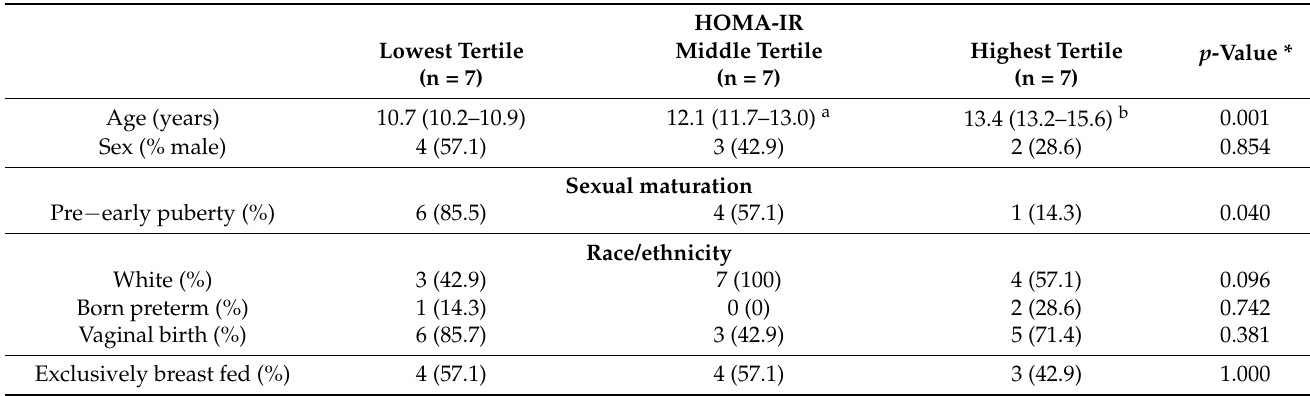
Table 1. Participants’ characteristics stratified by data-driven tertiles of the homeostatic model assessment for insulin resistance (HOMA-IR) (N =